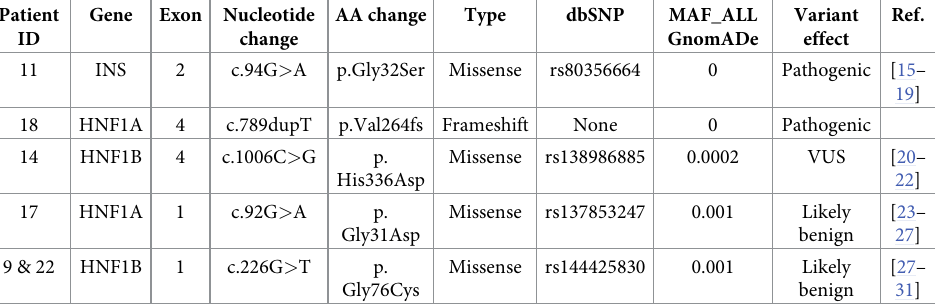
Table 4. Rare genetic variants in MD genes identified in patients with suspected T1D and negative